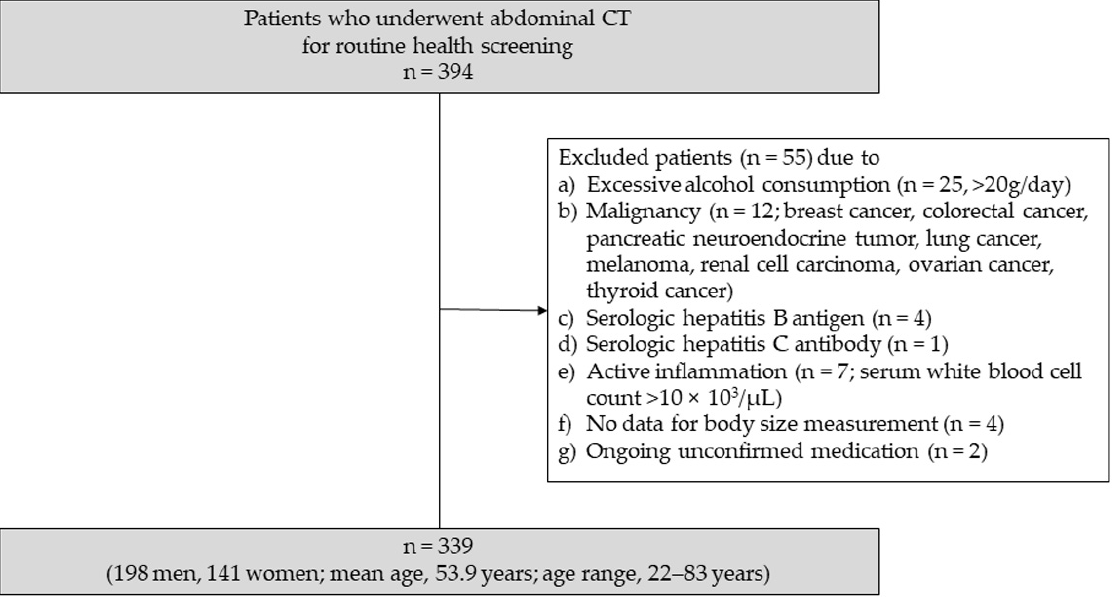
Figure 1. Flow chart of the patient population and study